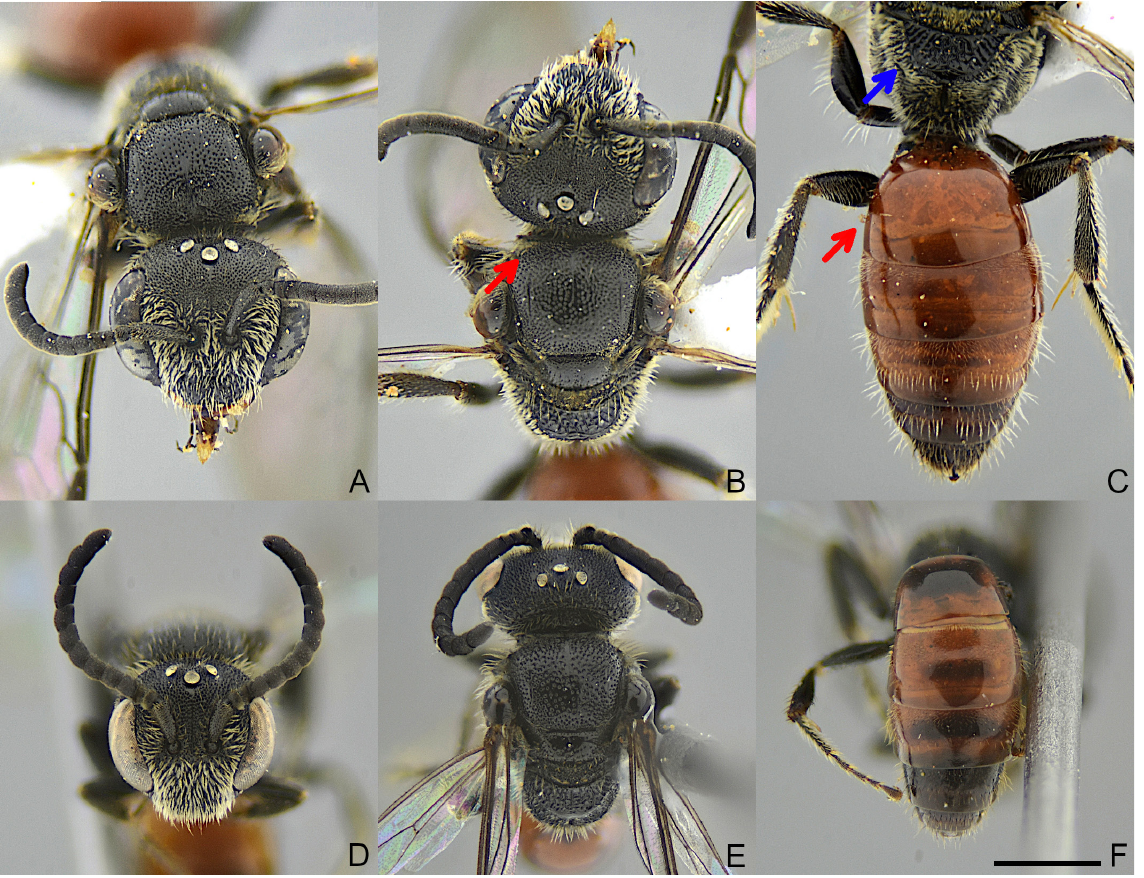
Fig. 1. Austrosphecodes asmodeus sp. nov. A – C . Holotype, ♀ (DZUP 411614). D – F . Paratype, ♂ (DZUP 572413). A . Female head. B . Female mesosoma, red arrow: punctate anterior margin of mesoscutum. C . Female propodeum and metasoma, blue arrow: metapostnotum trapezoidal, red arrow: puncticulate terga. D . Male head. E . Male mesosoma. F . Male metasoma. Scale bar = 1